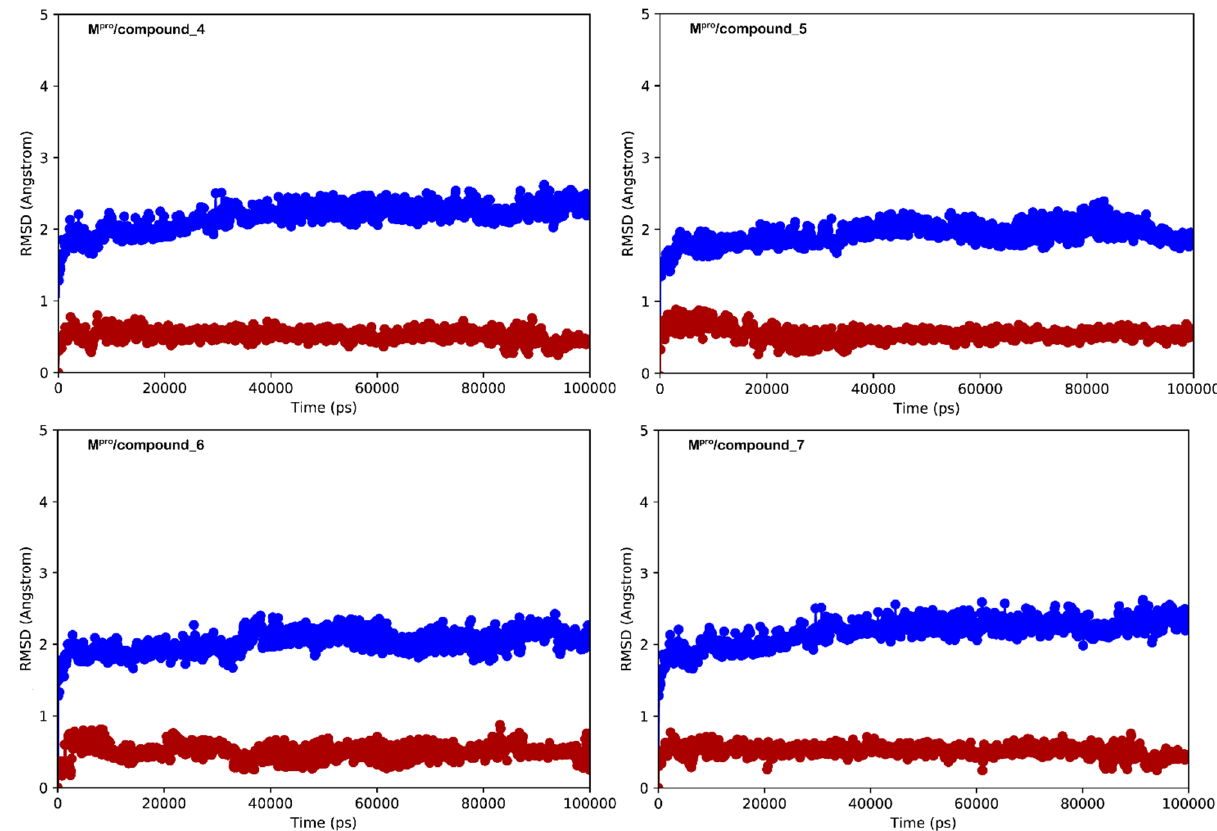
Figure 6. RMSD calculation for each complex investigated in this study: protein (blue line) and ligand (red line). Pictures were generated by Maestro (Maestro, Schrödinger LLC, release 2020-3).